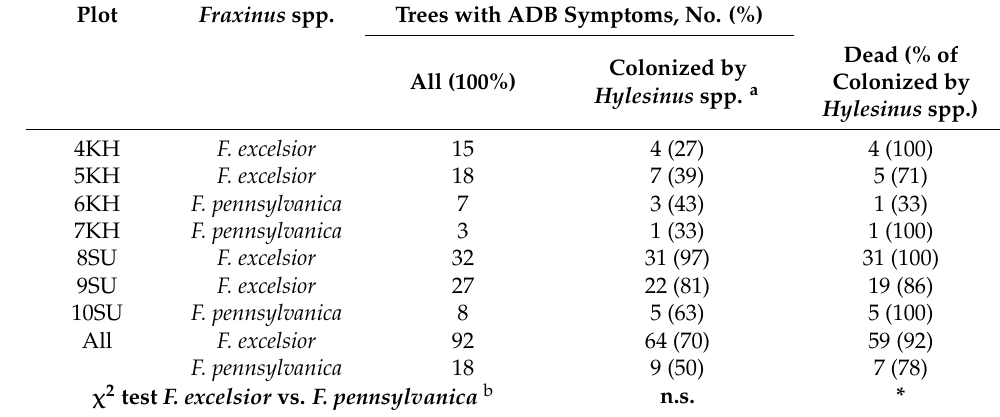
Table 2. Colonization by the ash bark beetles ( Hylesinus spp.) on trees of Fraxinus excelsior and F. pennsylvanica infected by the ash dieback disease (ADB) fungus Hymenoscyphus fraxineus . The plots are as shown in Figure 1.